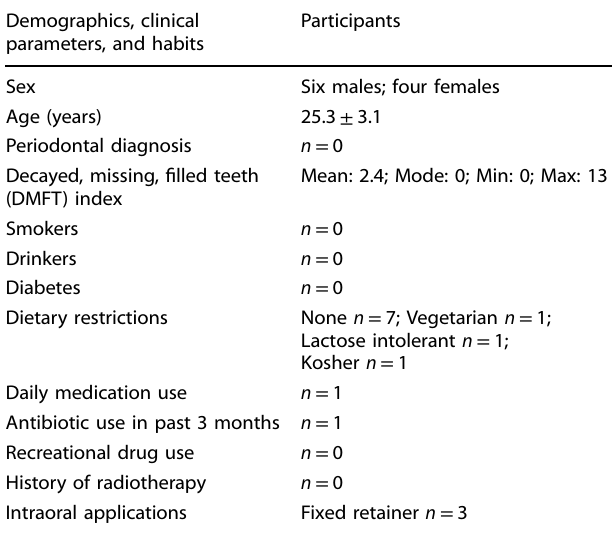
Table 1. Summary of subject demographic information Demographics, clinical parameters, and